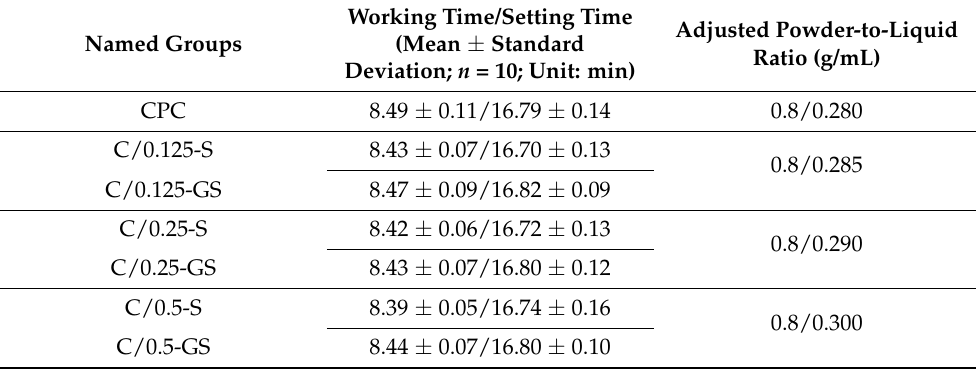
Table 1. Designated names of CPC composite hydrogels with different volume ratios, measured work/setting time, and relative powder-to-liquid